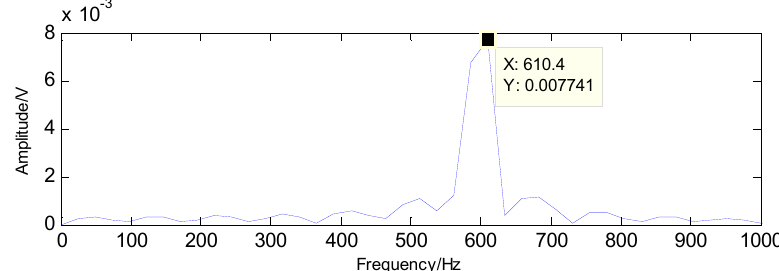
Figure 31. The detected fault characteristic frequency through matching pursuit.